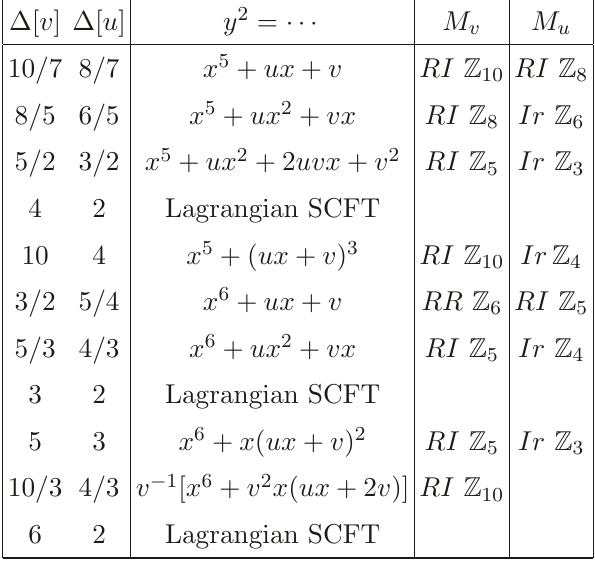
Table 6 . Geometries in refs. [19, 20] with univalued symplectic structure. First two columns give the Coulomb dimensions, third the family of hyperelliptic curves, third and fourth the regular- ity/irregularity of the rays along the axes together with the corresponding unbroken R